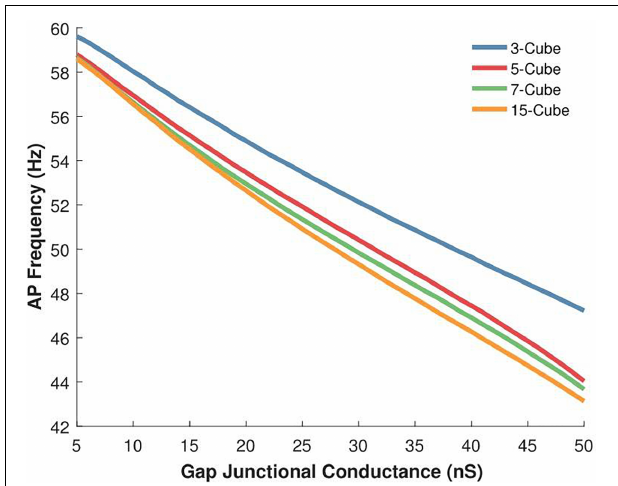
FIGURE 7 | Variations in the action potential oscillation frequency measured in 3-D syncytia of differing sizes for a range of gap junctional conductances (5 to 50 nS). The inverse relation between gap junctional coupling strength and oscillation frequency is observed for the three-dimensional syncytial model, irrespective of its size. For a given coupling strength, the AP firing rate is higher in smaller sized syncytia and this progressively reduces with increase in the size of the